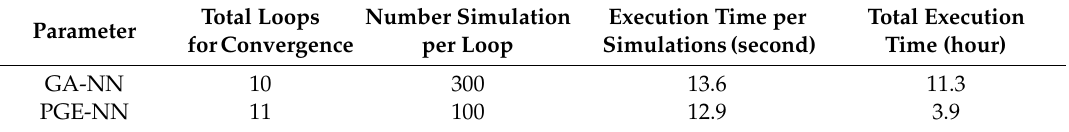
Table 3. Comparison of the execution time between GA-NN and PGE-NN with 30 neurons.